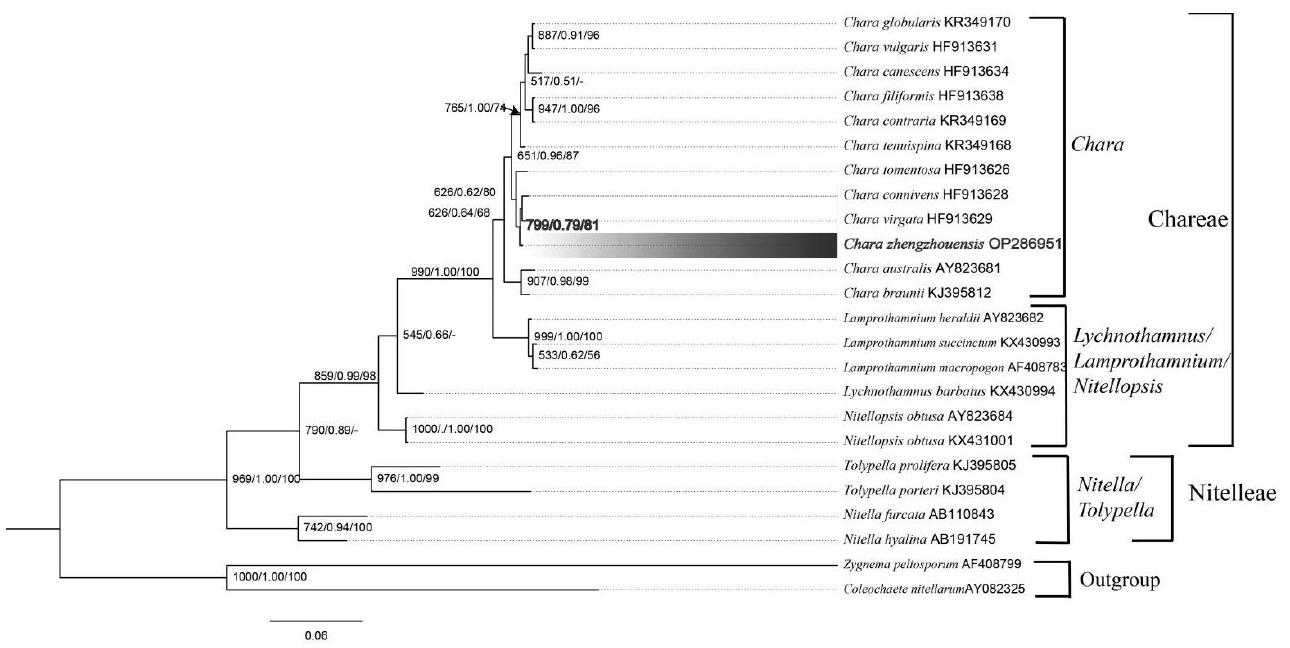
Figure 6. The phylogenetic tree constructed from atp B sequences. The numbers on the branch nodes represent the maximum likelihood bootstrap tree support values, Bayesian posterior probabilities, and neighbor joining bootstrap tree support values. Supporting values below 50% were noted with “ - ”.